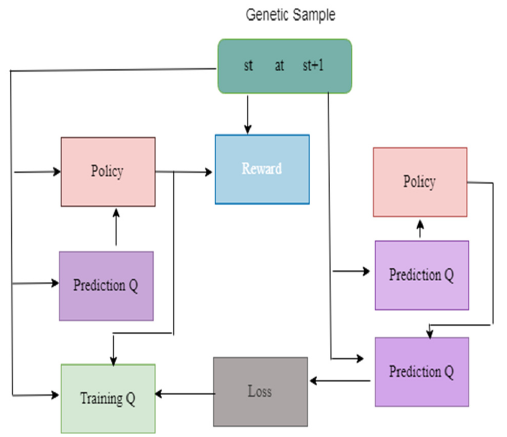
Figure 4. Framework of the DQN Model .